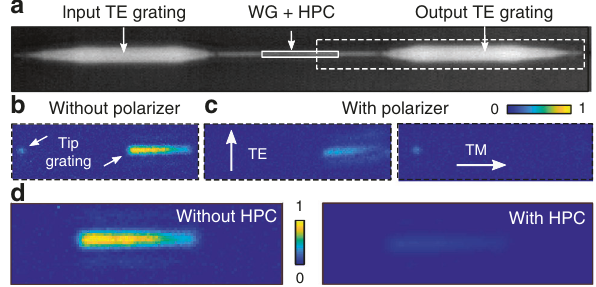
Fig. 4 Measurements of polarization rotation. a Microscope image of a 20 μ m WG with an HPIC (SEM inset). Light is coupled to the waveguide using a TE grating at input. b Measured light from the output TE grating and the tip (dashed line in ( a )). c Placing a polarizer between scattered light and camera con fi rms that light from the tip is TM polarized, while light from the grating is TE polarized. White arrows in ( c ) show polarizer orientation. d Measured light scattered by the output grating with and without the HPIC, resulting in 13% relative transmittance. Colorscale in ( b ), ( c ), and ( d ) represents the number of photon counts measured by the InGaAs camera, divided by the maximum number of counts measured in ( b ) and ( d ),